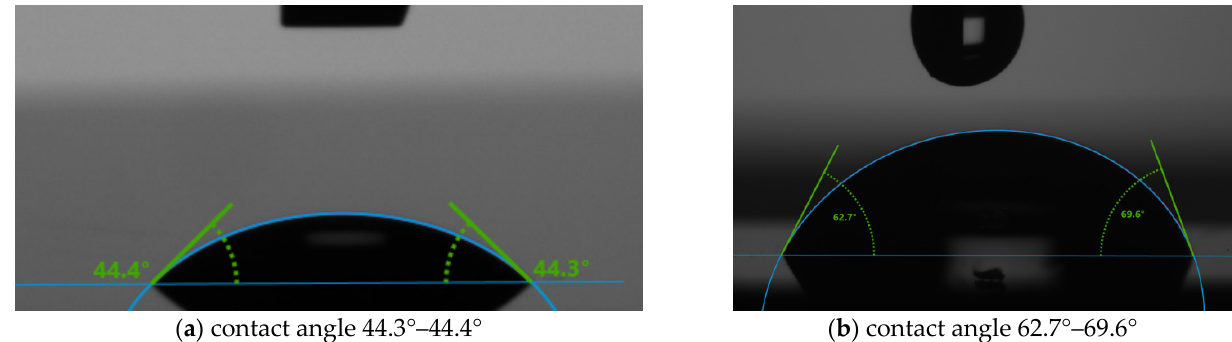
Figure 3. The contact angle of 2.5% PVA on Silicon ( a ) without plasma treatment and ( b ) with plasma treatment.